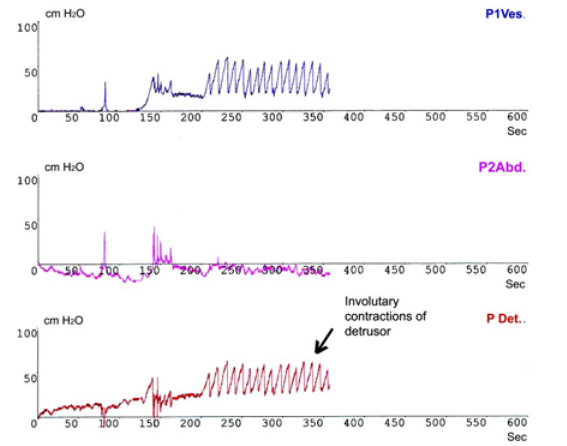
Figure 1 – Cystometric study of a rabbit in the group with par- tial bladder outlet obstruction (G2). A) Vesical pressure (P1Ves) O. B) Abdominal pressure (P2Abd) in cm H in cm H 2 untary contractions of the detrusor muscle (P Det) in cm H